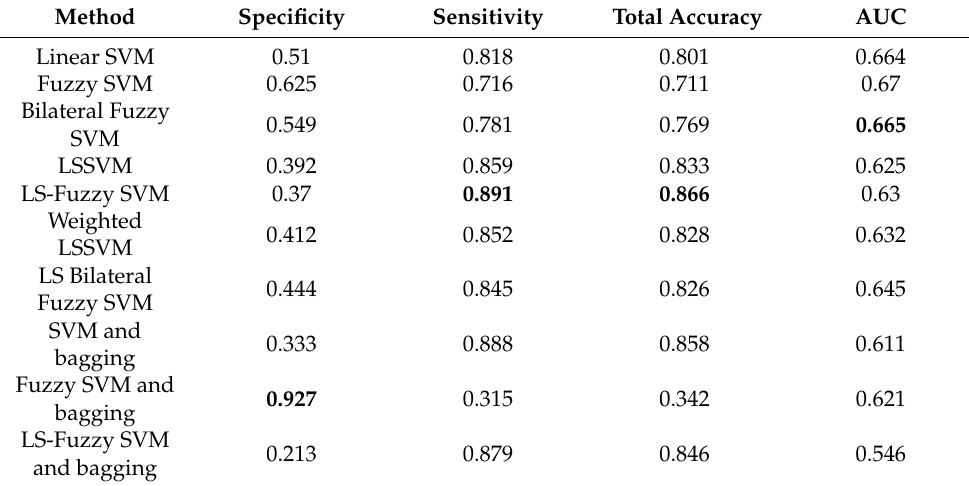
Table 2. Results for SVM-based methods.